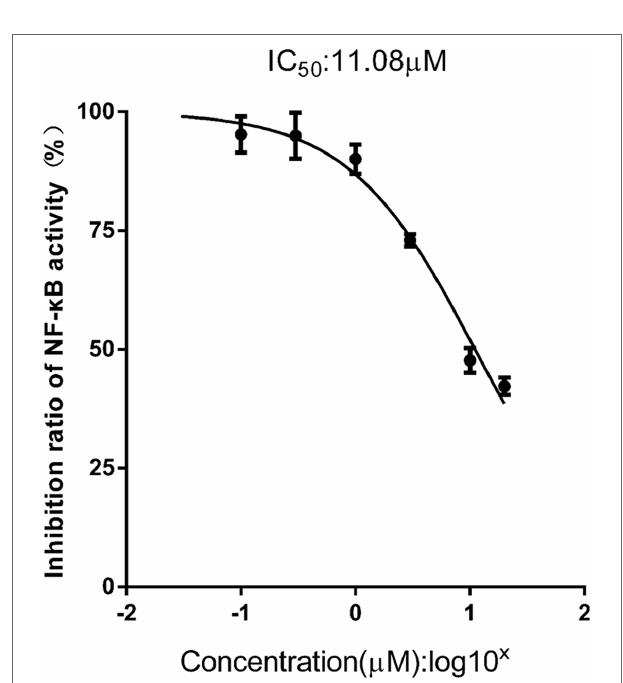
FIGURE 9 | FX reduces NF- κ B activity in THP1-Lucia™ NF- κ B cells treated with LPS stimulus. THP1-Lucia™ NF- κ B cells were pretreated with FX (0.03 – 30 μM) and then challenged with LPS (1.0 mg/L). FX showed a dose-dependent reduction in NF- κ B activity in THP1-Lucia™ NF- κ B cells stimulated with LPS (1.0 mg/L). Based on the logistic dose response curves, the 50% inhibitory concentration (IC 50 ) of the FX in decreasing NF- κ B activity was 11.08 ± 0.78 μM. n = 5 for each treatment group. The data are representative of three independent